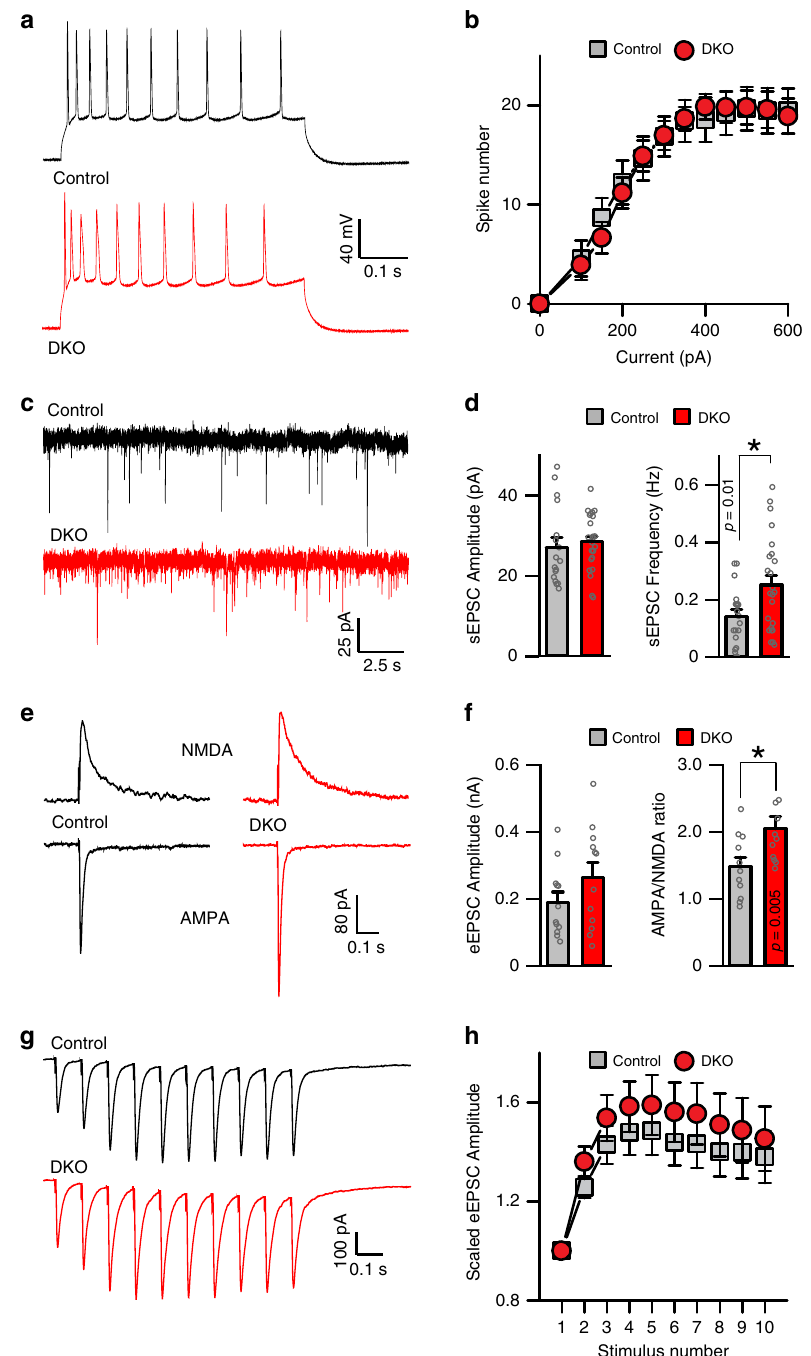
Fig. 5 Physiological properties of HDAC4/5-de fi cient excitatory neurons. Intrinsic excitability and synaptic strength of CA1 pyramidal cells were assessed by electrophysiological whole-cell recordings from acute brain slices from p20 mice. a Sample traces of depolarization-induced action potentials monitored in current-clamp mode. b Averaged numbers of action potentials, plotted as a function of stimulus intensity. Control: n = 5 mice/18 neurons; DKO: n = 3/ 27. c Sample traces of spontaneous miniature excitatory postsynaptic currents (sEPSCs) recorded in voltage-clamp mode. Holding potentials were − 70 mV. d Averaged sEPSC amplitudes and frequencies. Control: n = 5 mice/20 neurons; DKO: n = 5 /26. e Traces of evoked AMPA (inward) and NMDA (outward) excitatory postsynaptic currents (eEPSCs) monitored at − 70 and + 40 mV holding potentials, respectively, in the presence of the GABA receptor blocker, Picrotoxin (50 μ M). Synaptic responses were triggered by electrical stimulation of CA3 afferents in the Schaffer collateral path. f Averaged AMPA eEPSC amplitudes (left) and AMPA/NMDA ratios (right). Control: n = 3 mice/11 neurons; DKO: n = 3/11. g Sample traces of AMPA eEPSC elicited by repetitive stimulation at 10 Hz. h Averaged eEPSC amplitudes during 10 Hz trains, normalized to amplitudes of fi rst responses. Control: n = 5 mice/22 neurons; DKO: n = 5/22. All quanti fi cations are represented as Mean ± SEM. * p < 0.05 ( t